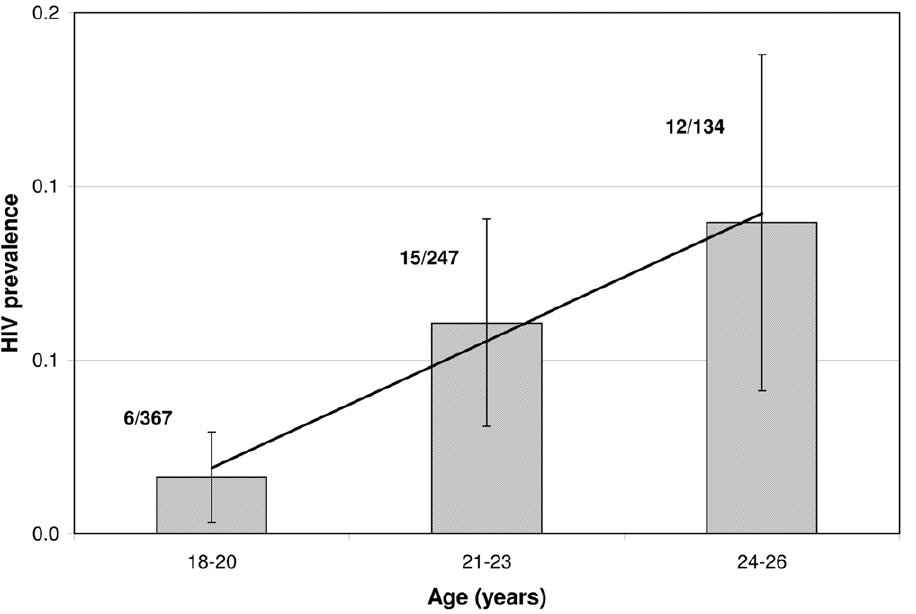
Figure 2. HIV prevalence by age obtained among uncircumcised men of the Orange Farm Community. This figure represents the HIV prevalence by age, with 95% confidence intervals, obtained among a random sample of uncircumcised men of the Orange Farm (South Africa) Community in 2007. A linear regression line has been added to the data.